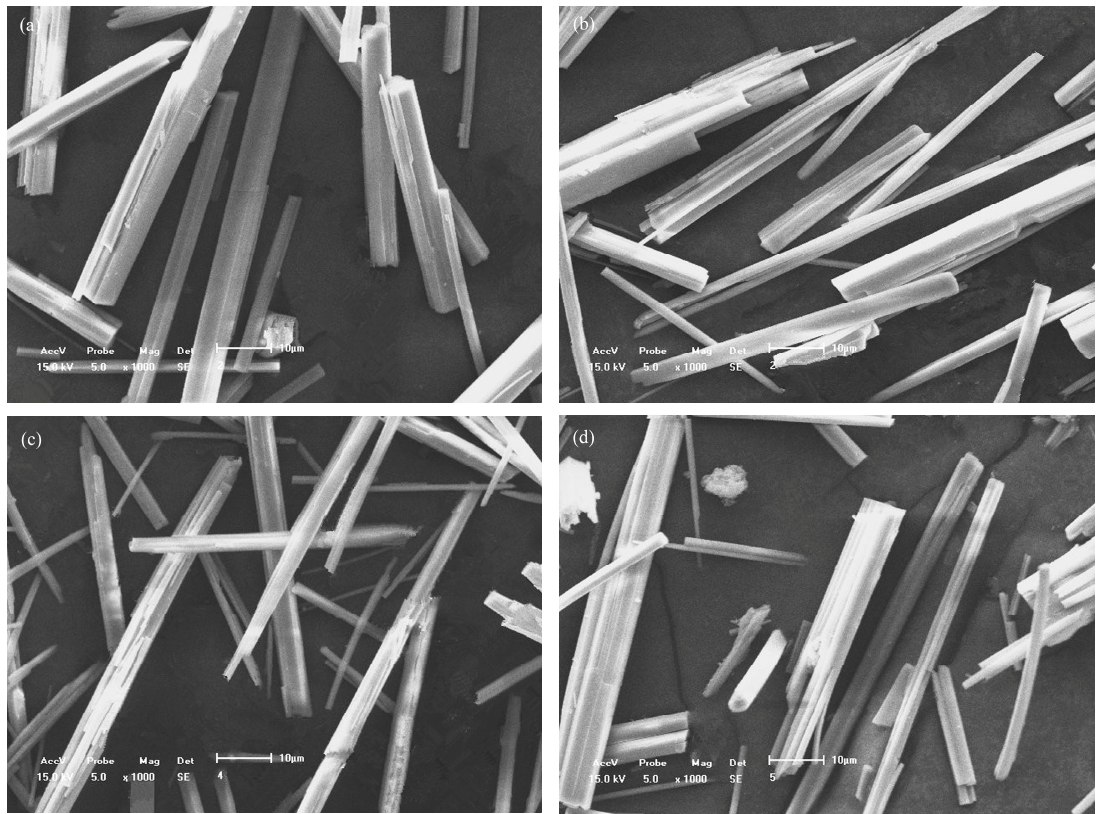
Figure 3. Morphologies of the synthesized products ( a ) without additives and in the presence of ( b ) sodium oleate, ( c ) SDBS, and ( d ) sodium citrate.